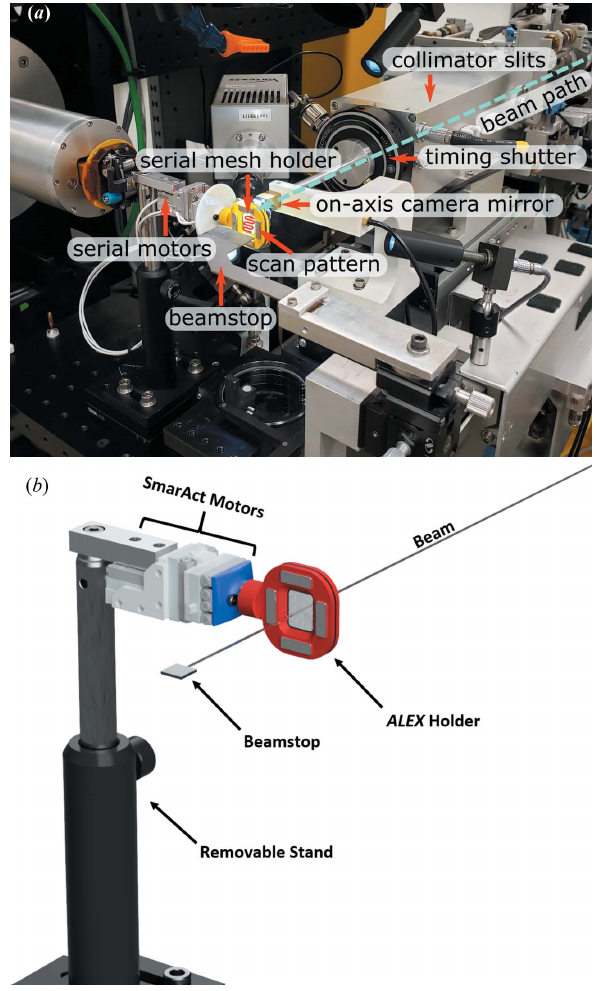
Figure 2 Setup of ALEX at the 19-ID beamline ( a ) using a modular magnetic mount prior to permanent integration onto the goniostat (used in data collection reported here), and ( b ) schematic of permanent integration onto the goniostat with upgraded